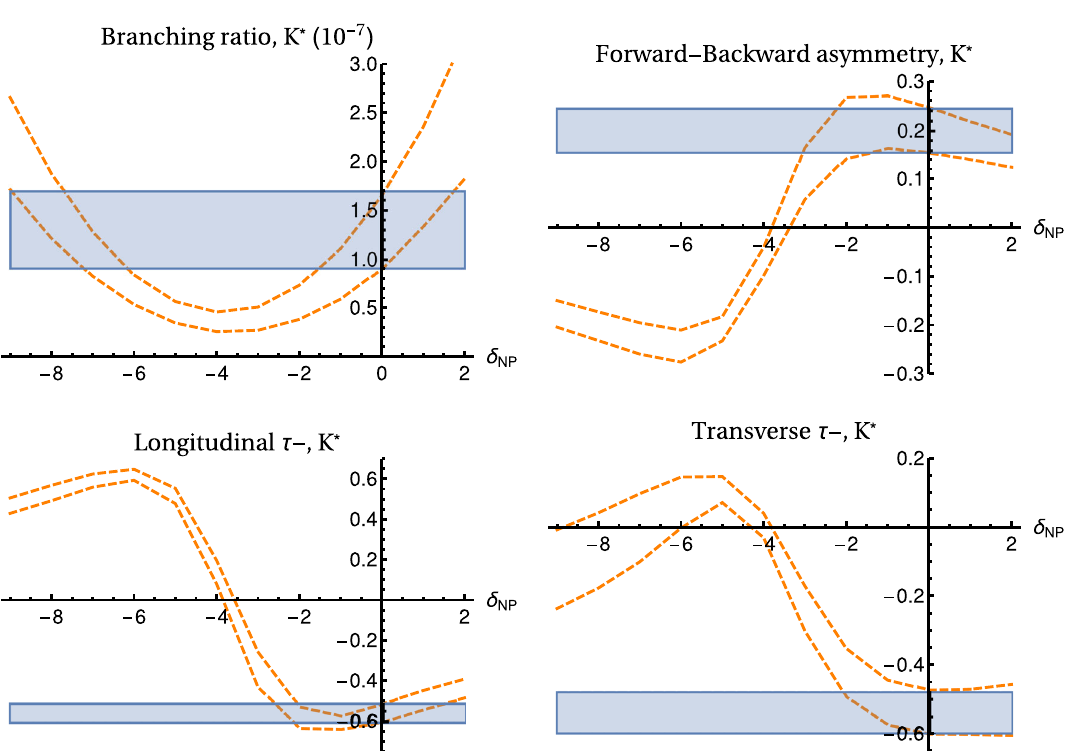
Fig. 4 New physics effects in the form of a real δ C 9 ≡ δ NP , whose values are given in the horizontal axes. The vertical axes give the val- ues of the branching ratio, the FB asymmetry and the longitudinal and transverse polarizations of the τ − , in the SM (solid, filled blue, inde-